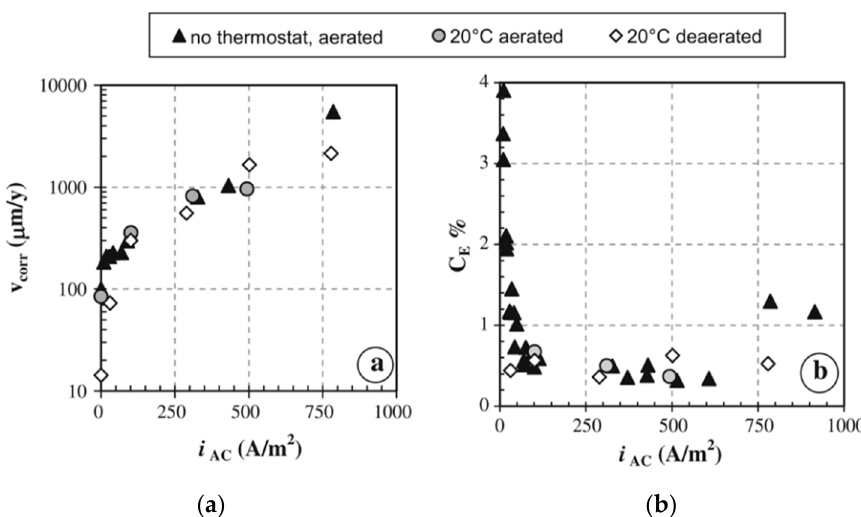
Figure 1. Weight loss tests on carbon steel in free corrosion condition exposed to a soil-simulating solution: ( a ) corrosion rates vs. AC density ( i AC ) and ( b ) AC corrosion efficiency vs. AC density ( i AC ) as reported by Goidanich et al. [16].